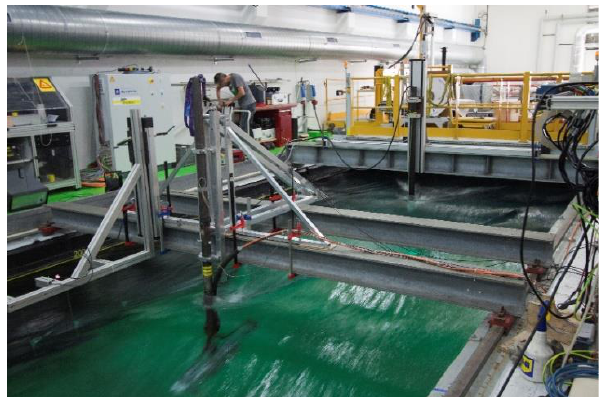
Figure 4. Turbine installed at the flume facility at